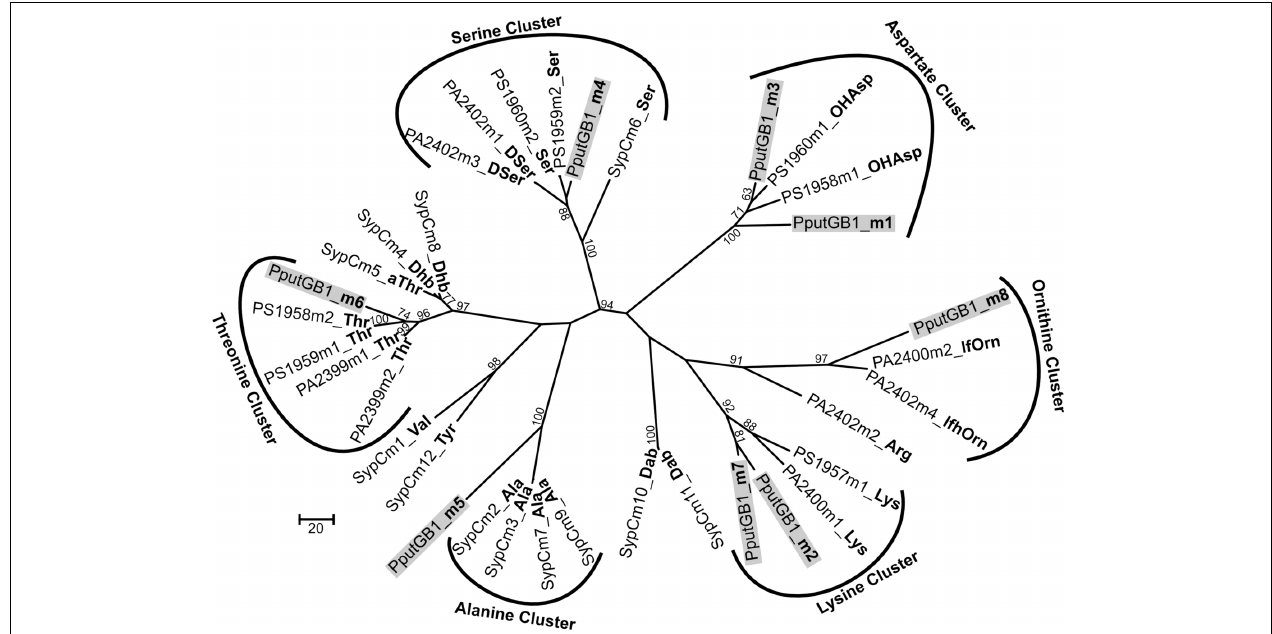
FIGURE 3 | Phylogenetic cluster analysis using MUSCLE performed for selected adenylation domains among pseudomonads along with 8 adenylation domains found in the genome of P. putida GB-1 in PputGB1_4086-4083.